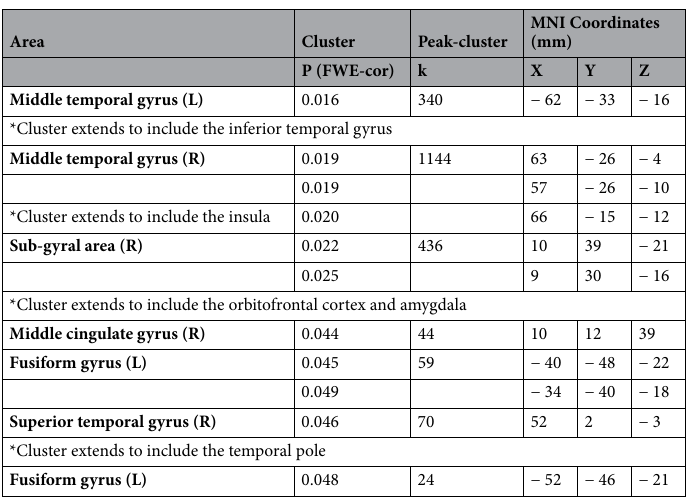
Table 4. The coordinates for the local maxima obtained via a two-sample t-test, comparing the hearing loss group without tinnitus to the control group. The areas identified show less gray matter volume in the hearing loss group without tinnitus compared to the